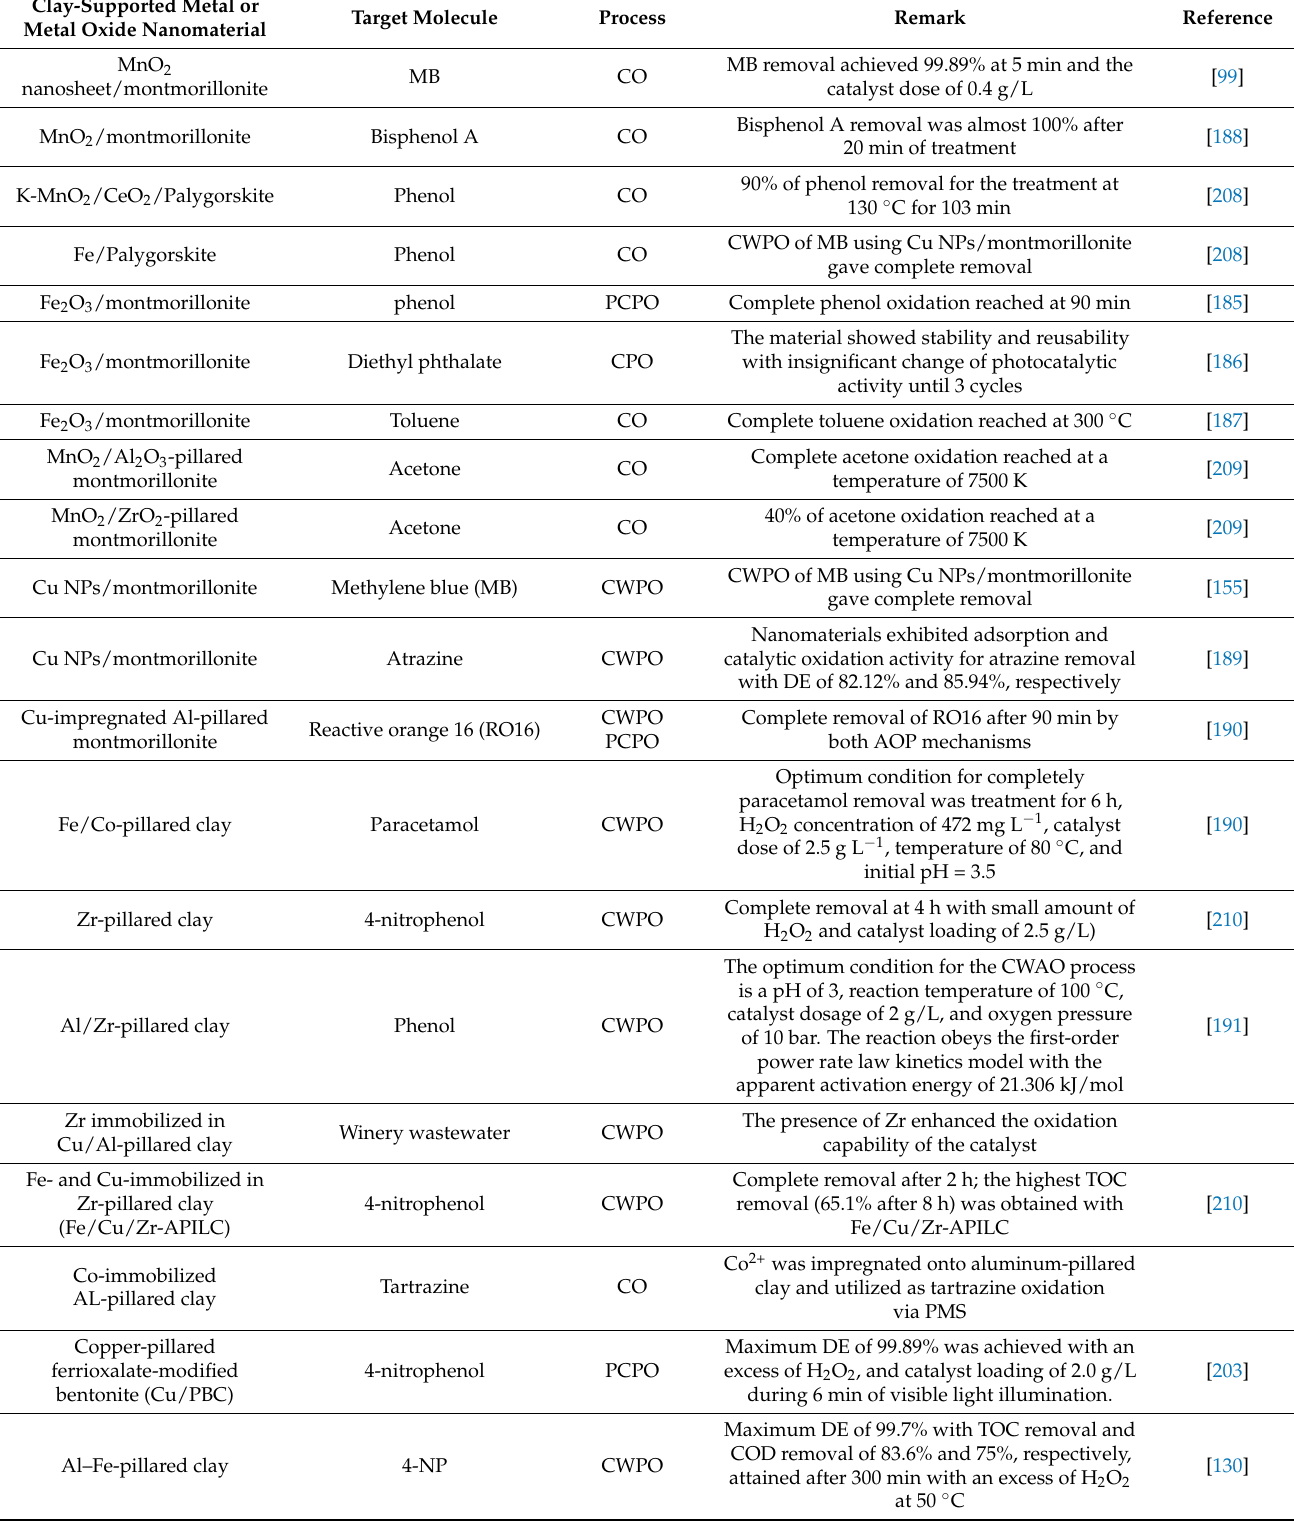
Table 3. Some clay-supported metal or metal oxide nanomaterial for AOPs